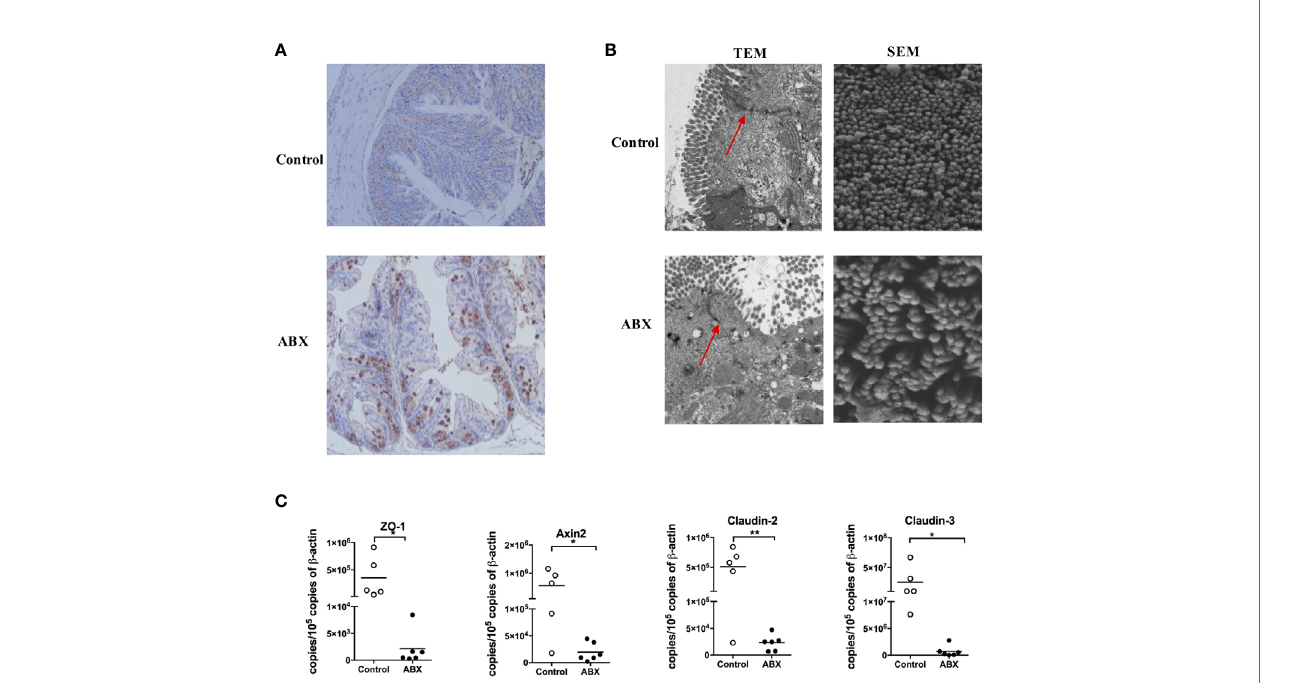
FIGURE 2 | Gut microbiota depletion impaired the epithelial integrity of the colon. (A) IHC staining of E . coli in colon tissue sections of control and ABX mice after being fed with water or ABX for four weeks (magni fi cation 200×). (B) The morphology of epithelia in the colon evaluated using TEM and SEM at 5000× and 60000× magni fi cation, respectively. (C) The mRNA levels of molecules related to barrier function assayed via qPCR. n = 4-10/group, *P < 0.05, **P <